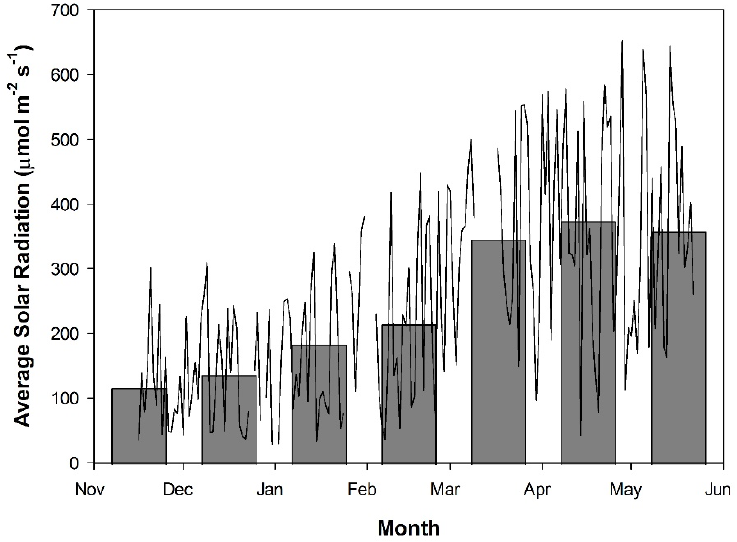
Figure 2. Daily average solar radiation as measured from 16 November 2018 to 22 May 2019 using a Li-COR LI-200R pyranometer converted from W m -2 to µmol m -2 s -1 using the conversion value of 2.1. Readings were taken above the greenhouse and then corrected for an approximate 50% transmissivity to account for shading from the greenhouse structure, lighting fixtures, and shade curtains. Measurements were taken every 2 h, beginning at 08:00 and concluding at 16:00, between the wavelengths of 400 and 1100 nm. Measurements during this period were averaged to provide an average solar radiation for each day (line plot). The bar graph indicates the average daily solar radiation throughout the month. Breaks in the line plot indicate periods of time which were not documented due to a technical malfunction.